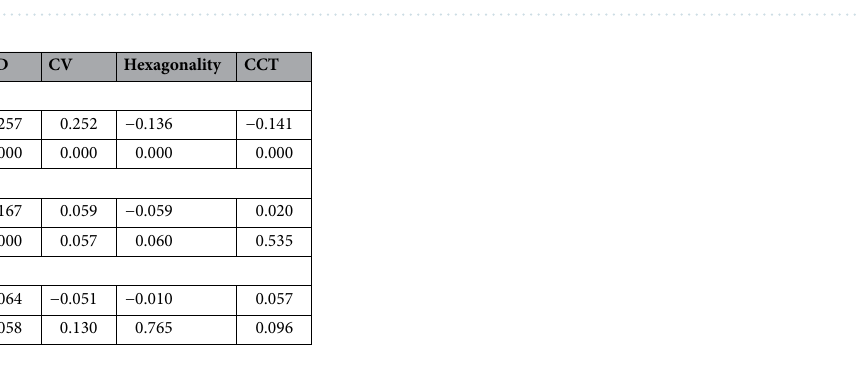
Figure 4. Comparisons of the mean values of ECD ( A ), CV ( B ), hexagonality ( C ) and CCT ( D ) of the diabetic groups based on HbA1c% across all age groups. ECD Endothelial cell density, CV Coefficient of variation, CCT Central corneal thickness.